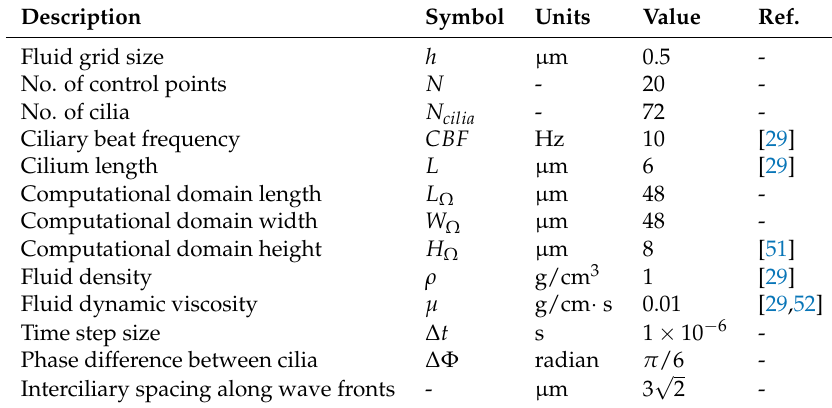
Figure 3. Code validation at Re = 0.01. ( a ) Results for fluid velocity for the Couette flow comparing the present simulation results with the analytical solution. ( b ) Results for streamlines for a lid-driven cavity comparing the present code results (‘ − .’) with the works of Shankar [48] (‘ − ’) and Pan and Acrivos [49] (‘ (cid:52) ’). Table 3. Parameters used in the simulations. L , ρ , µ , and o of cilia are the standard parameter set, which can have different values depending on the type of our parametric studies.